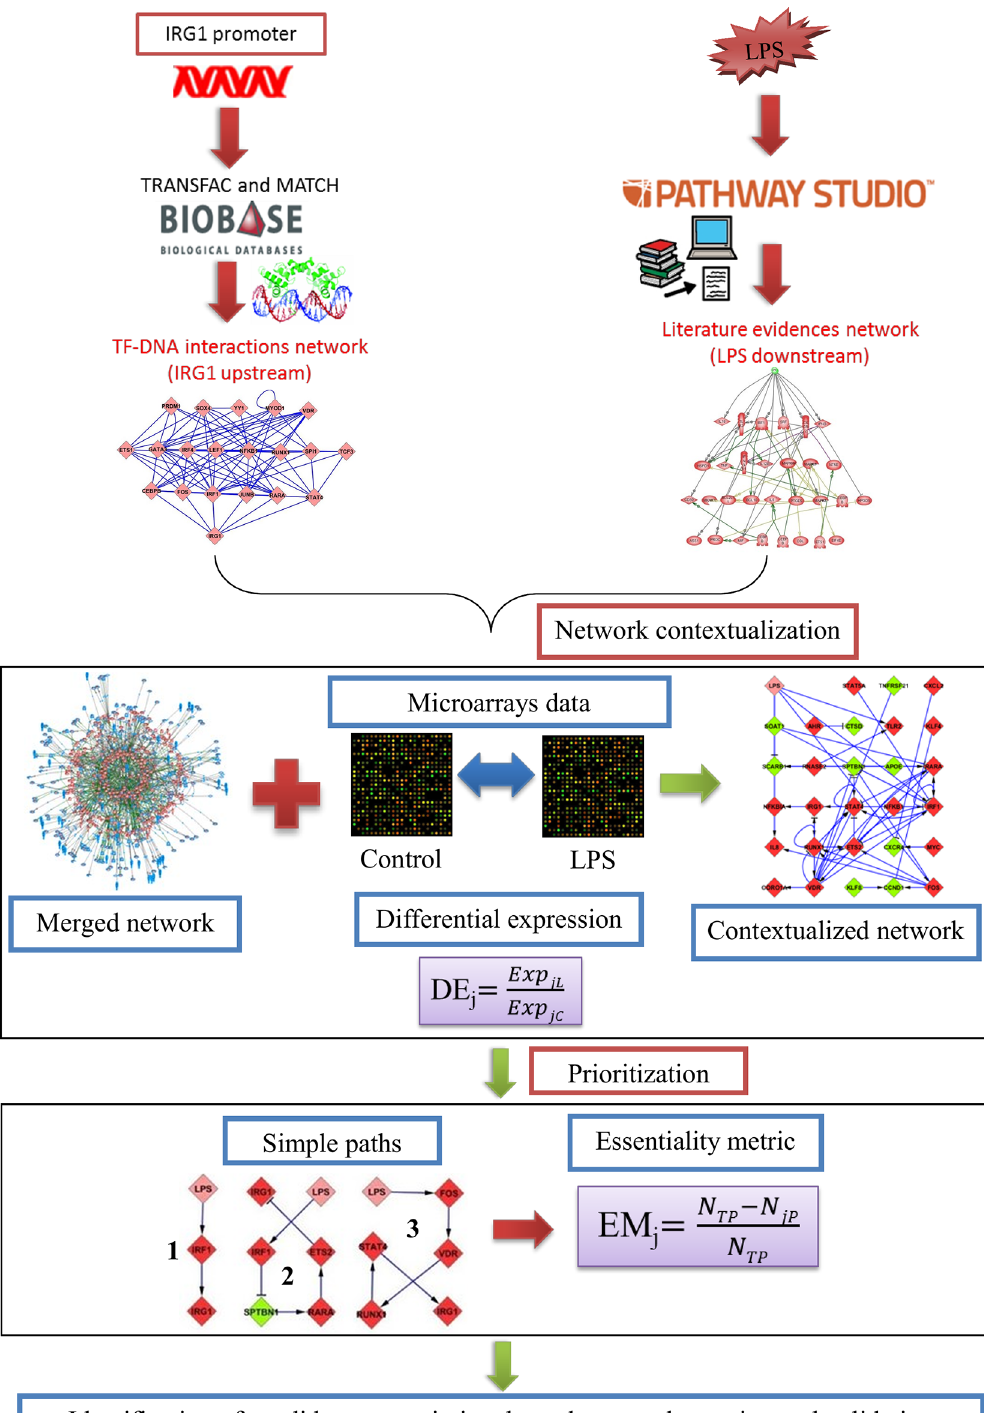
Fig 1. Workflow for the identification of transcriptional regulators for a specific gene. The scheme shows the workflow of the different steps followed to identify potential transcriptional regulators for a given gene under LPS exposure. The upstream network was initially constructed using the PWMs from TRANSFAC 1 and the prediction algorithm MATCH ™ . The literature network downstream of LPS was inferred using the Pathway Studio knowledge database. These networks were merged and the merged network was contextualised using the booleanised genome-wide expression data. Finally, the ranking scheme with simple paths and essentiality metric resulted in a set of potential transcriptional regulators which were tested using siRNA mediated gene silencing experiments.